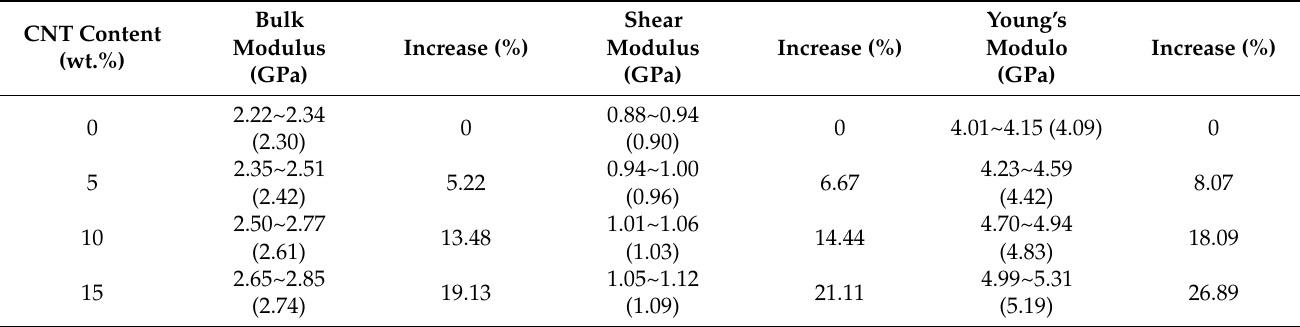
Table 1. Bulk, Shear modulus and Young’s modulo results and increase percentage compared to pure VNR. CNT Content